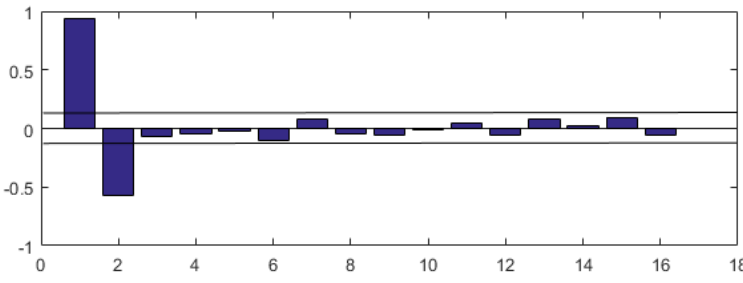
Figure 4. The partial auto correlation result of the overall power load.